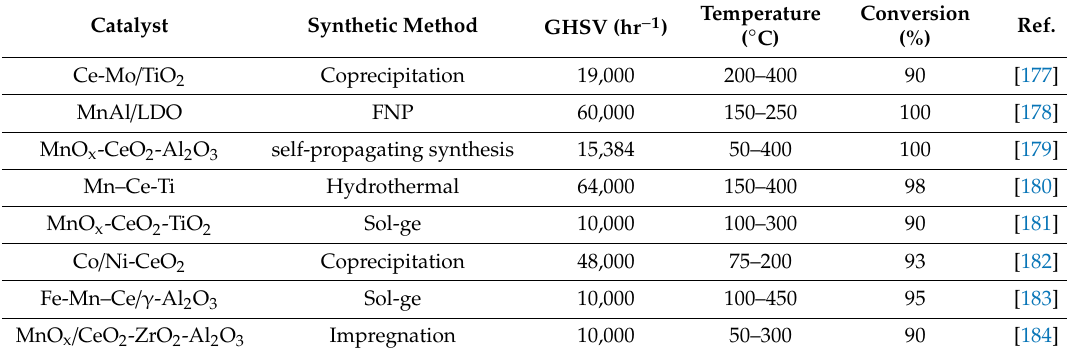
Table 4. E ff ects of di ff erent synthetic methods on de-NO x activity of NH 3 -SCR.